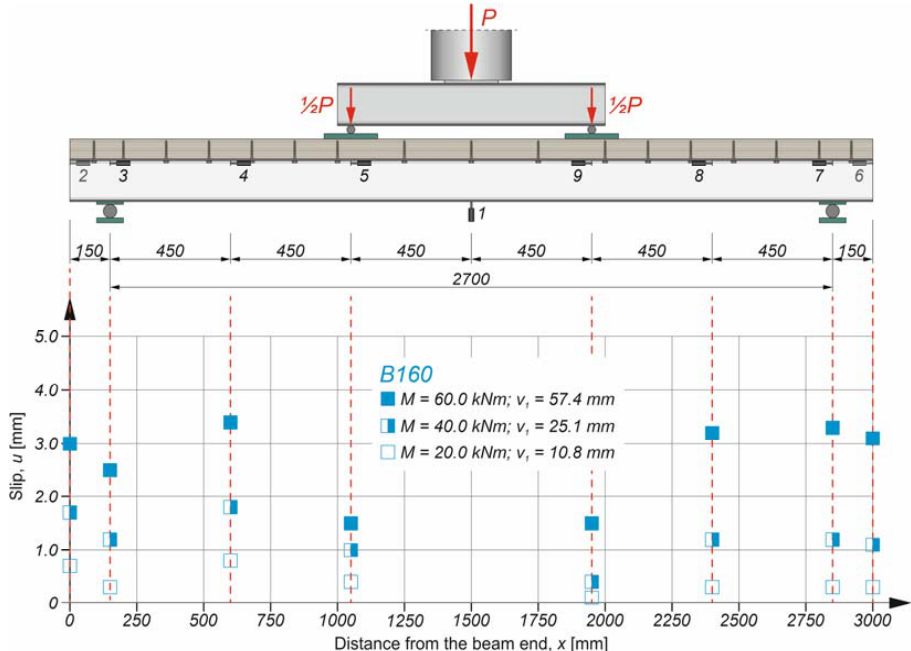
Figure 9. Slip distribution in the B160 composite beam.